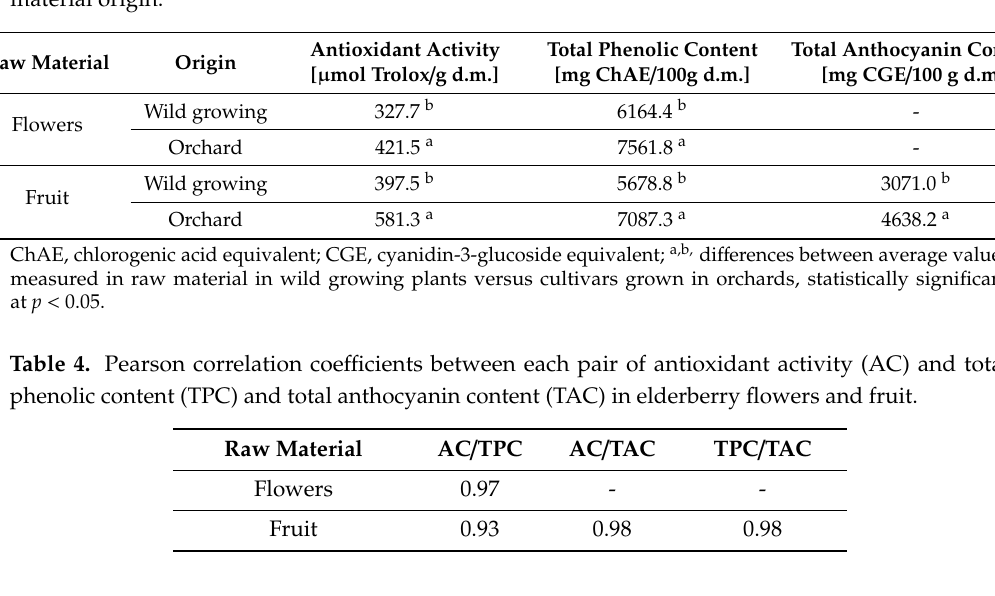
Figure 3. Total anthocyanin content in elderberry fruit, depending on location (wild plants) or cultivar. (a,b,c,d) Differences between average values, statistically significant at p < 0.05. CGE, cyanidin-3-glucoside equivalent. Table 3. Average values of bioactive properties of elderberry flowers and fruit, depending on raw material origin.